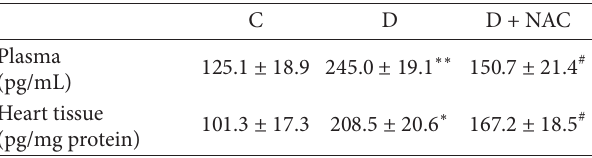
Table 2: Effects of NAC treatment on the level of free 15-F isoprostane in plasma and heart